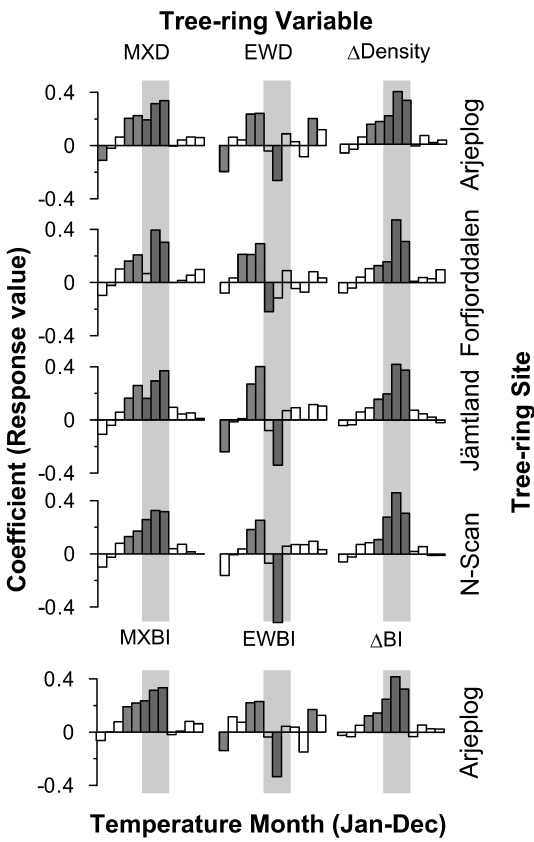
Fig. 6. Monthly temperature response on different tree-ring pa- Figure 6. Monthly temperature response on different tree-ring parameter chronologies from 2 rameter chronologies from Arjeplog, Forfjorddalen, Jämtland and Arjeplog, Forfjorddalen, Jämtland and Finland N-Scan. All chronology- and temperature-data 3 Finland N-Scan. All chronology and temperature data are trans- formed into first differences thus only taking the high frequency are transformed into first differences thus only taking the high frequency response into 4 response into account. Grey-shaded areas demarcate the summer account. Grey shaded areas demarcate the summer months (JJA). 5 months (JJA).